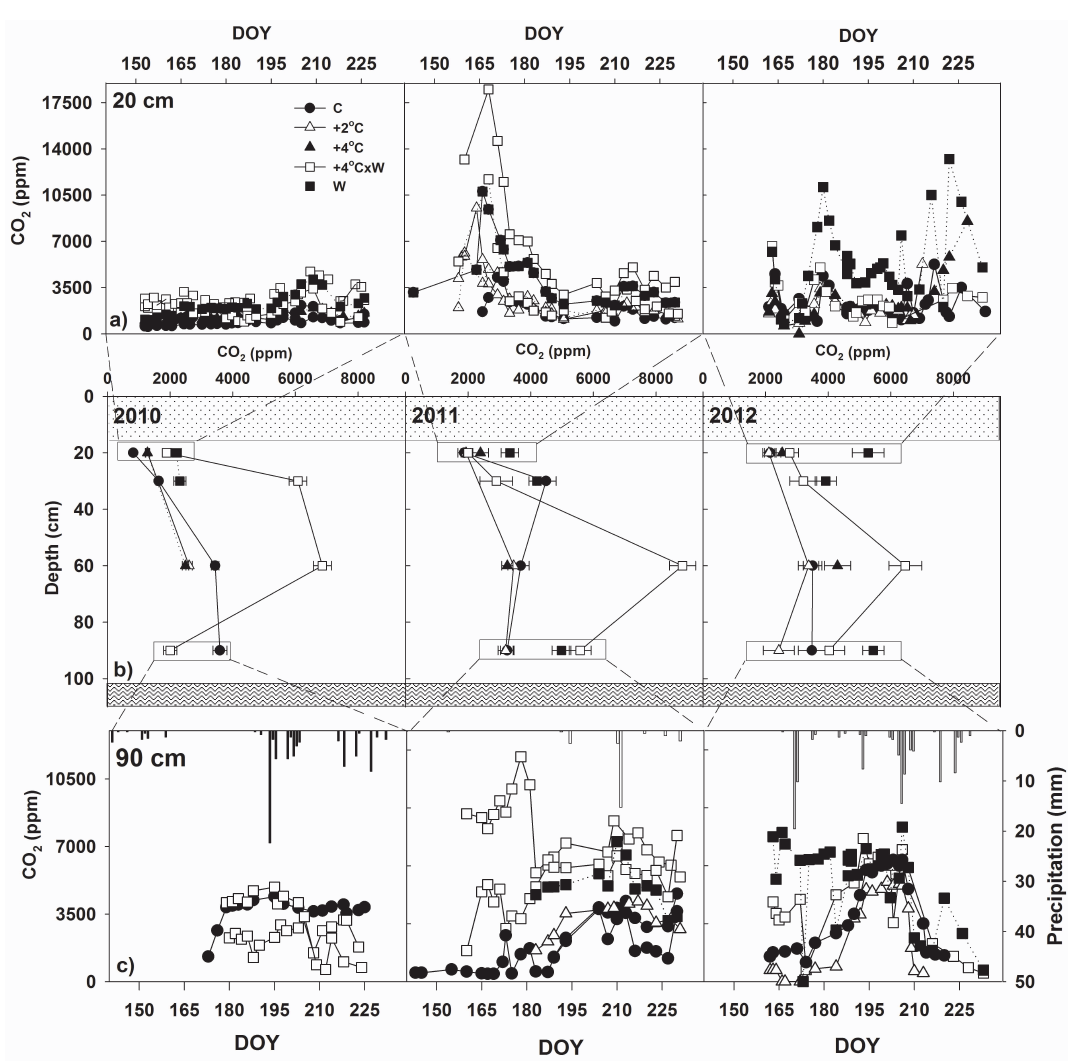
Figure 3. Middle panel: seasonal mean of pore space CO 2 concentration along the soil profile for the four treatments ( + 2 ◦ C, + 4 ◦ C, + 4 ◦ C × W and W ) and control over the sampling years 2010–2012 (hatched areas represent the estimated rooting zone, zig-zag areas represent the permafrost table). Top panel: pore space CO 2 concentration at 20cm depth. Bottom panel: pore space CO 2 concentration at 90cm depth and seasonal precipitation